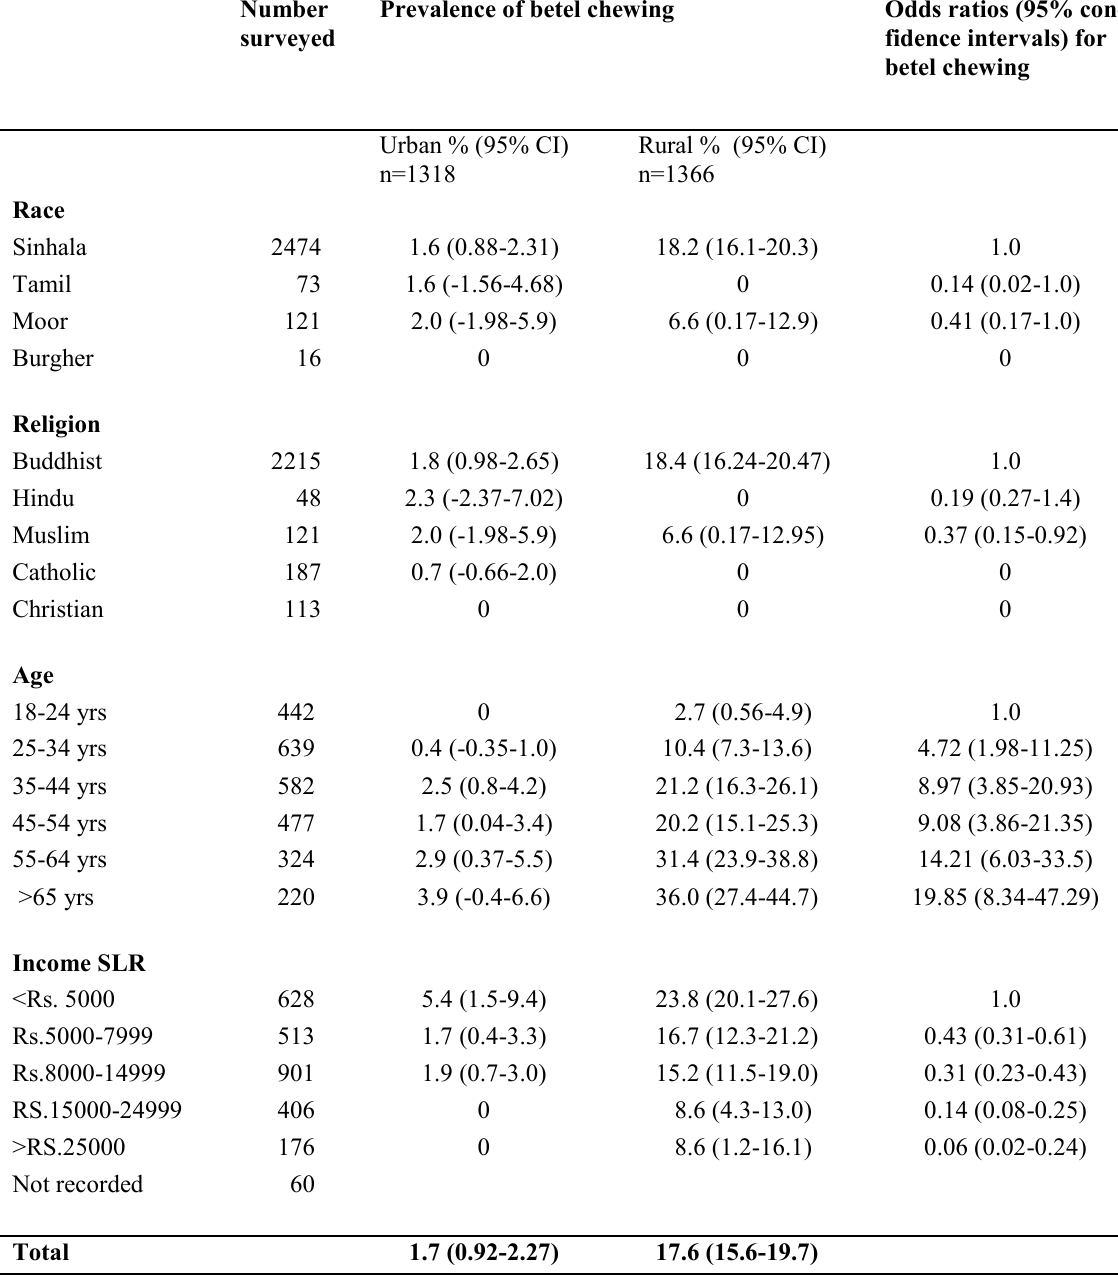
Table 1 Prevalence and odds ratio of betel chewing according